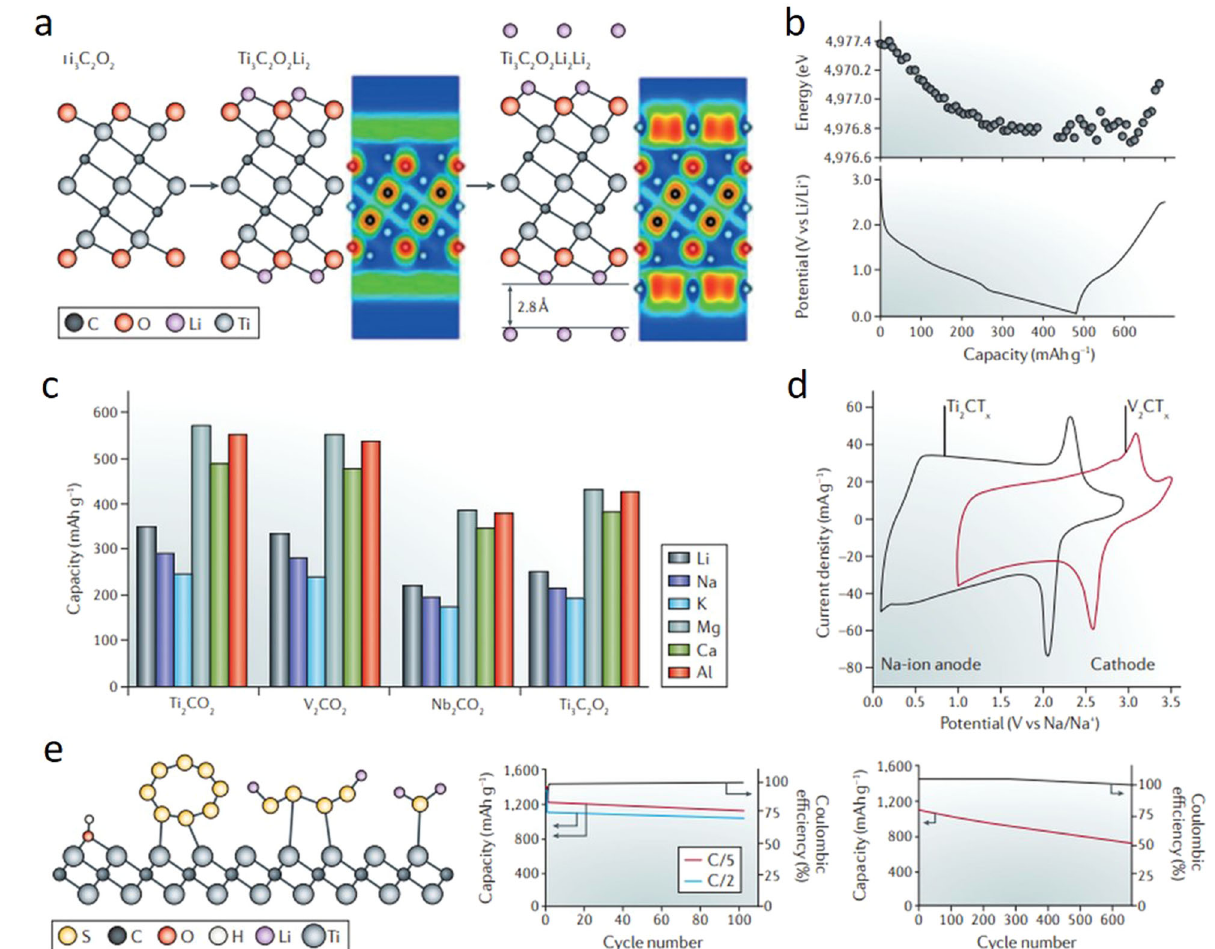
Fig. 8 MXenes as conductive electrodes in batteries. a Schematic representation of Li + insertion in the Ti 3 C 2 T x . Without and with the extra lithium fi lm, the valence electron localization functions are described. b Edge energy variation of titanium versus capacity of MXene during delithiation and lithiation process integrated along the analogous voltage contours. c On the oxygen-terminated MXene sheets, theoretical capacities of nonlithium and lithium ions were theoretically obtained. a – c reprinted with permission from 38 J ACS 2014, 136, 17, 6385 – 6394; Publication Date: March 28, (2014) https://doi.org/10.1021/ja501520b Copyright (2014) American Chemical Society; ( d ) Cyclic voltammetry (CV) curves of V 2 C and Ti 2 C in a Na + electrolyte. d reprinted with permission from 106 The journal of physical chemistry letters 2015, 6, 2305 – 2309; Publication Date: June 5, (2015) https://doi.org/10.1021/acs.jpclett.5b00868 Copyright (2015) American Chemical Society; e Performance representation of Ti 2 C – S MXene composite in Li – S batteries; A graphical demonstration of the substitution of the Ti – OH bond with S – Ti – C bond on the MXene surface upon treatment by heat or contacting with polysul fi des (presented on the leftward); the cyclic functioning of a 70 wt% d-Ti 2 C-S MXene composite at C/2 and C/5 (in middle); and long-period cycling at C/2 is presented on the rightward. Reprinted with permission from 112